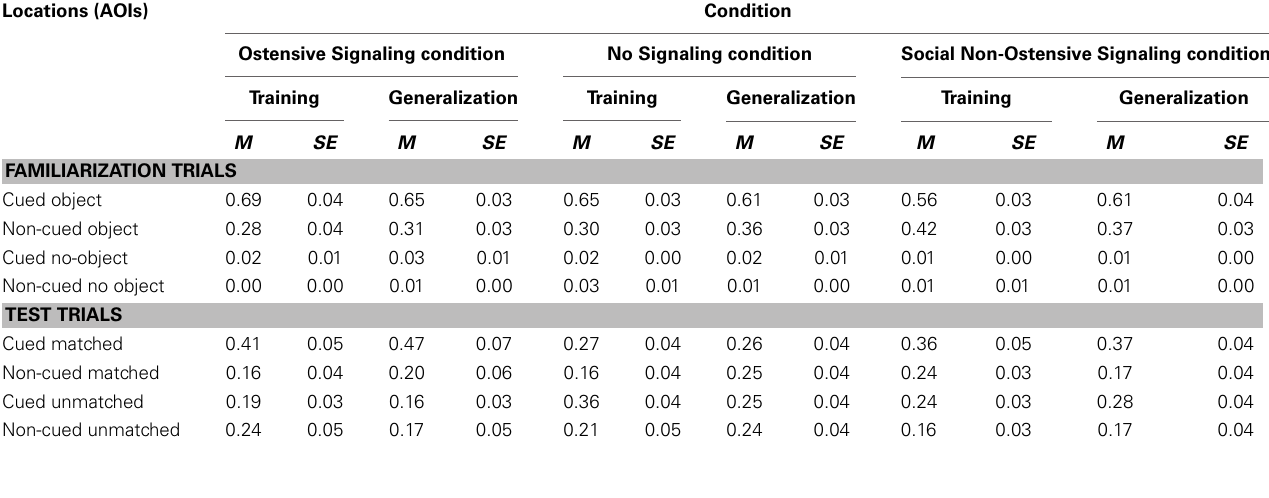
Table 1 | Mean proportional looking times during familiarization and test trials to four areas of interest (AOIs) in the Ostensive Signaling, No Signaling, and Social Non-Ostensive Signaling conditions.